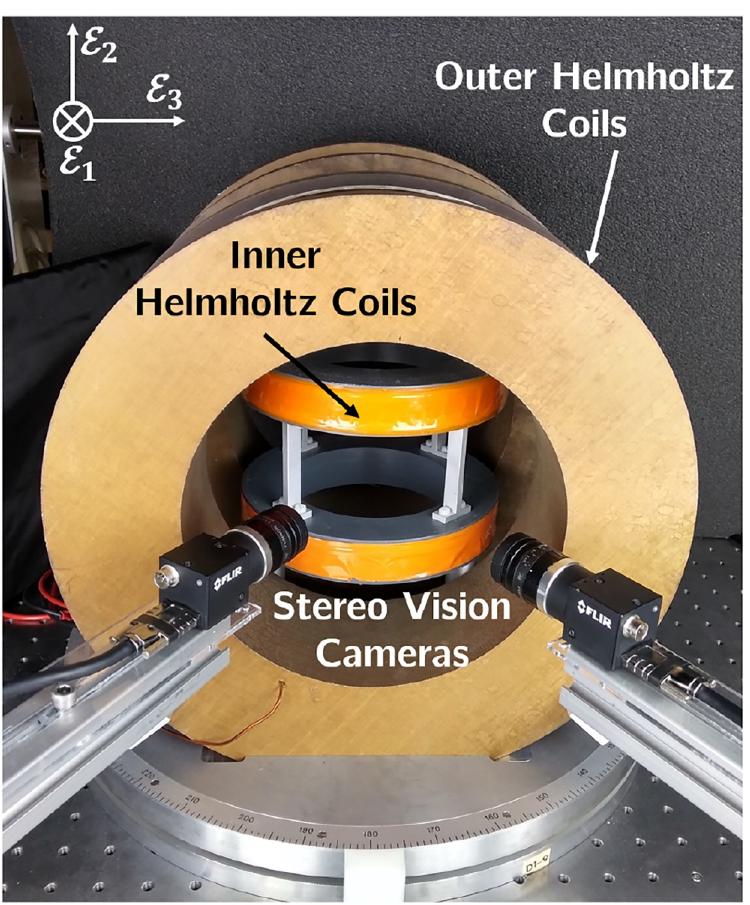
Fig 12. Magnetic field generation setup with the stereo vision cameras. Two nested pairs of Helmholtz coils generate uniform magnetic fields in E